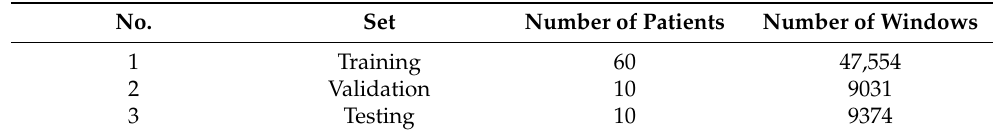
Figure 9. Illustration of 10-s non-overlapping moving windows. Table 1. Data proportion in the holdout